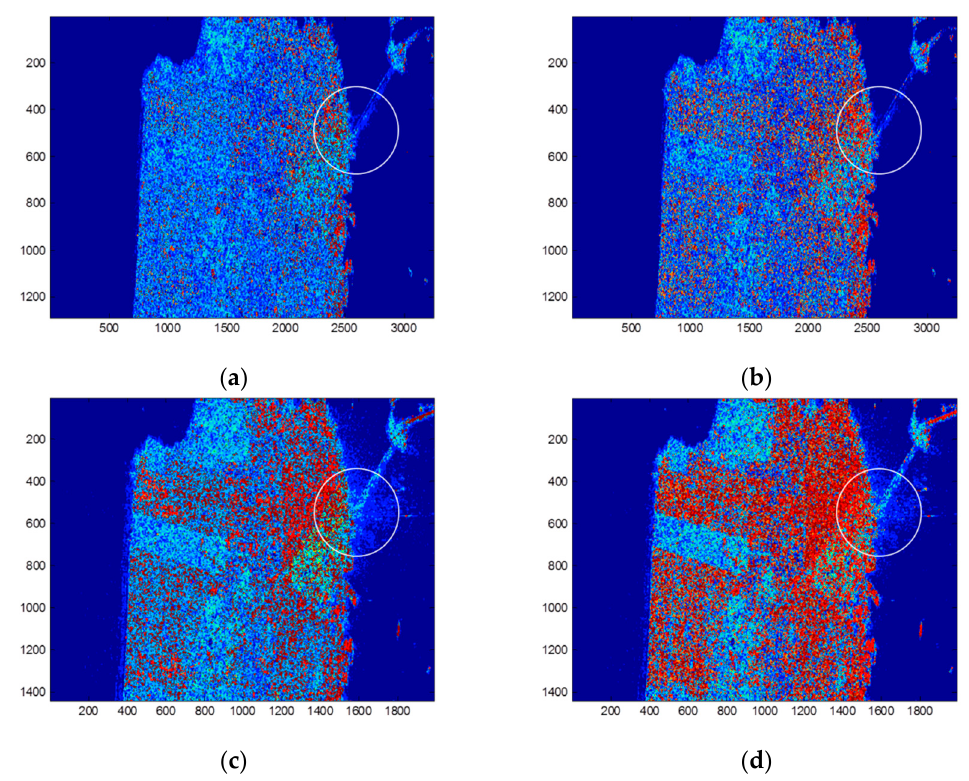
Figure 3. Physical scattering mechanism classification results by ( a ) the H / alpha method with GF-3 data; ( b ) the ∆ α B / α B method with GF-3 data; ( c ) the H / alpha method with Radarsat-2 data; and ( d ) the ∆ α B / α B method with Radarsat-2 data. The ocean surface in the white circle is easily affected by targets with strong backscatter on land.